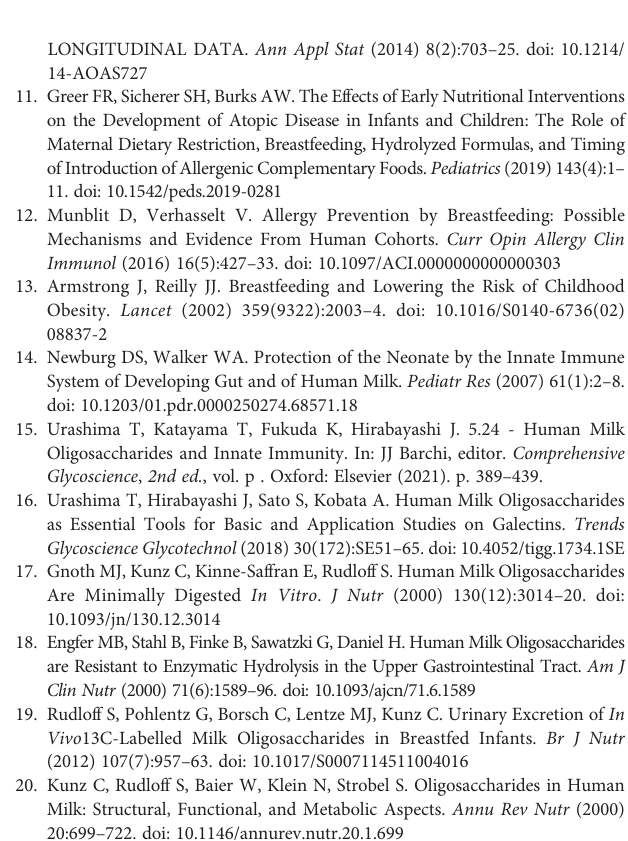
Supplementary Table 1 | The Panel of antibodies used for staining mesenteric lymph node and spleen